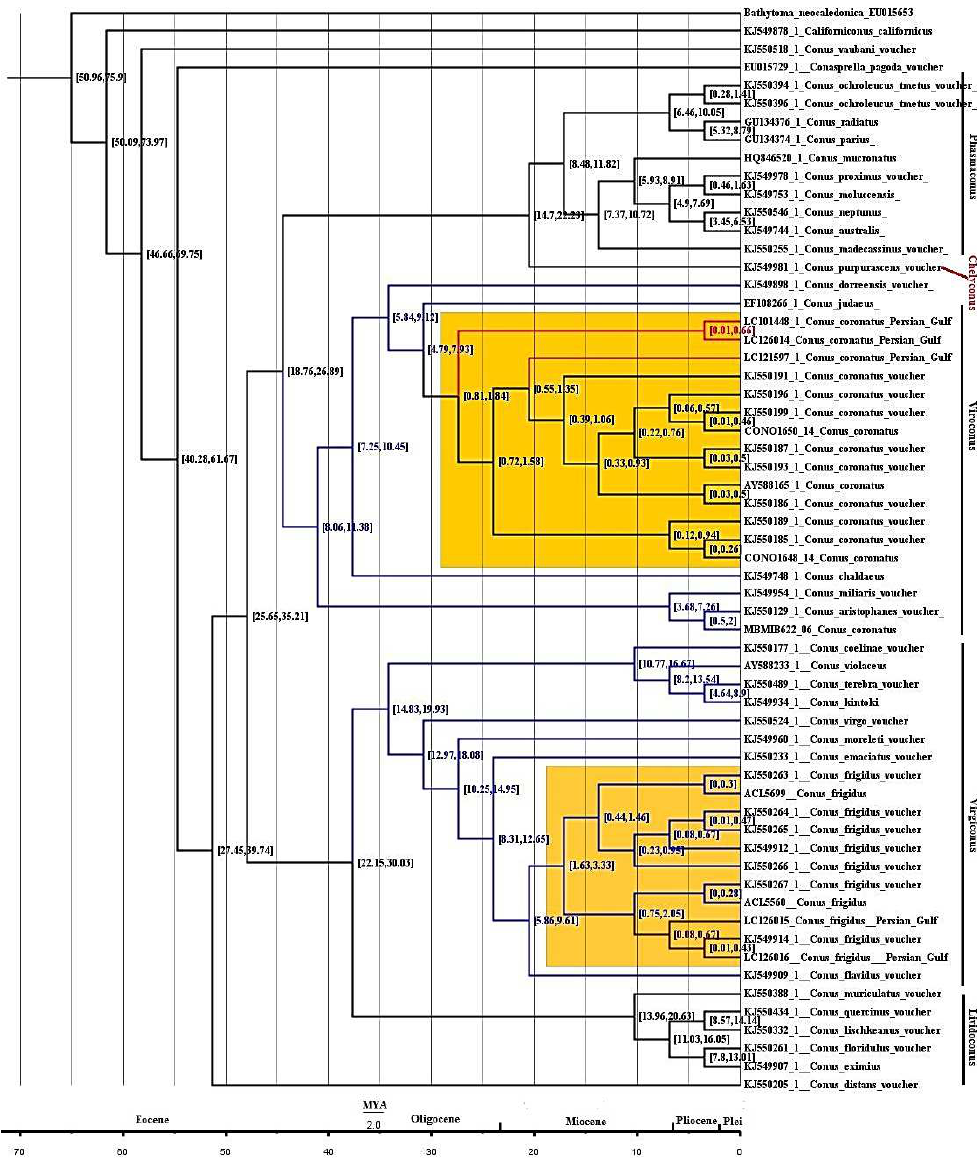
F IGURE 3. Molecular Phylogenetic tree and divergent time of Conus species from the Persian Gulf. The number of nodes were indicated the time of the divergent of the